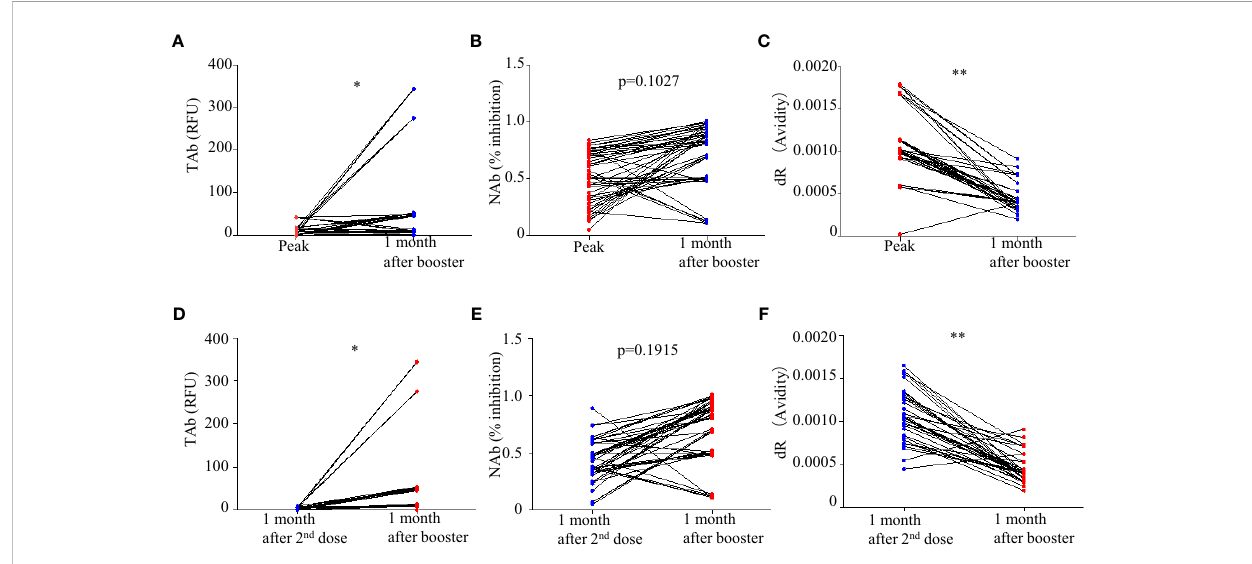
FIGURE 5 Comparison of antibody responses after the third doses (TP 7) with the peak responses after the second doses: (A) TAb (p <0.05, Wilcoxon test), (B) NAb (p = 0.1027, paired t-test), and (C) antibody avidity (p < 0.0001, paired t-test). (D – F) Comparison of antibody responses after the third doses (TP 7) with the second shots (TP4). * p<0.05 ** p<0.01.